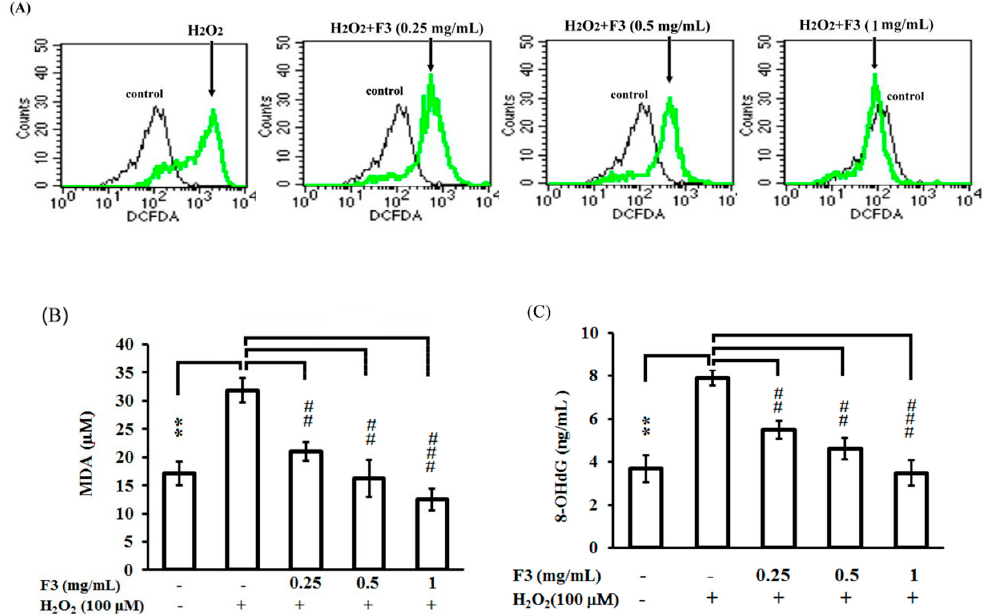
Figure 3. Effects of P. ginseng supercritical CO 2 extracted fraction F3 on H 2 O 2 -induced cellular oxidation in ARPE-19 cells. ARPE-19 cells were pretreated with or without a series of concentrations of F3 for 2 h, and then treated with 100 μ M H 2 O 2 for another 24 h. ( A ) Intracellular reactive oxygen species levels were measured by flow cytometry analysis; ( B ) malondialdehyde (MDA); and ( C ) 8-hydroxydeoxyguanosine (8-OHdG) contents were measured on a microplate reader (VersaMax, Mass, USA). MDA and 8-OHdG levels in the H 2 O 2 group increased significantly compared with the untreated group. F3 attenuated the H 2 O 2 -induced changes in MDA and 8-OHdG. ** p < 0.01 versus untreated group. ## p < 0.01, ### p < 0.001 versus H 2 O 2 group. Each value represents the mean ± SD of three independent experiments.